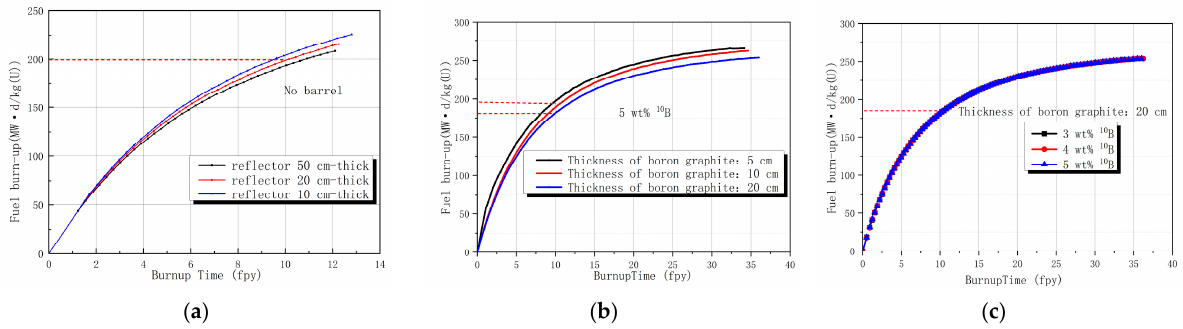
Figure 12. Burn-up depth in ( a ) scheme A, ( b ) scheme D with changed thickness of boron graphite and ( c ) scheme D with changed boron concentration.